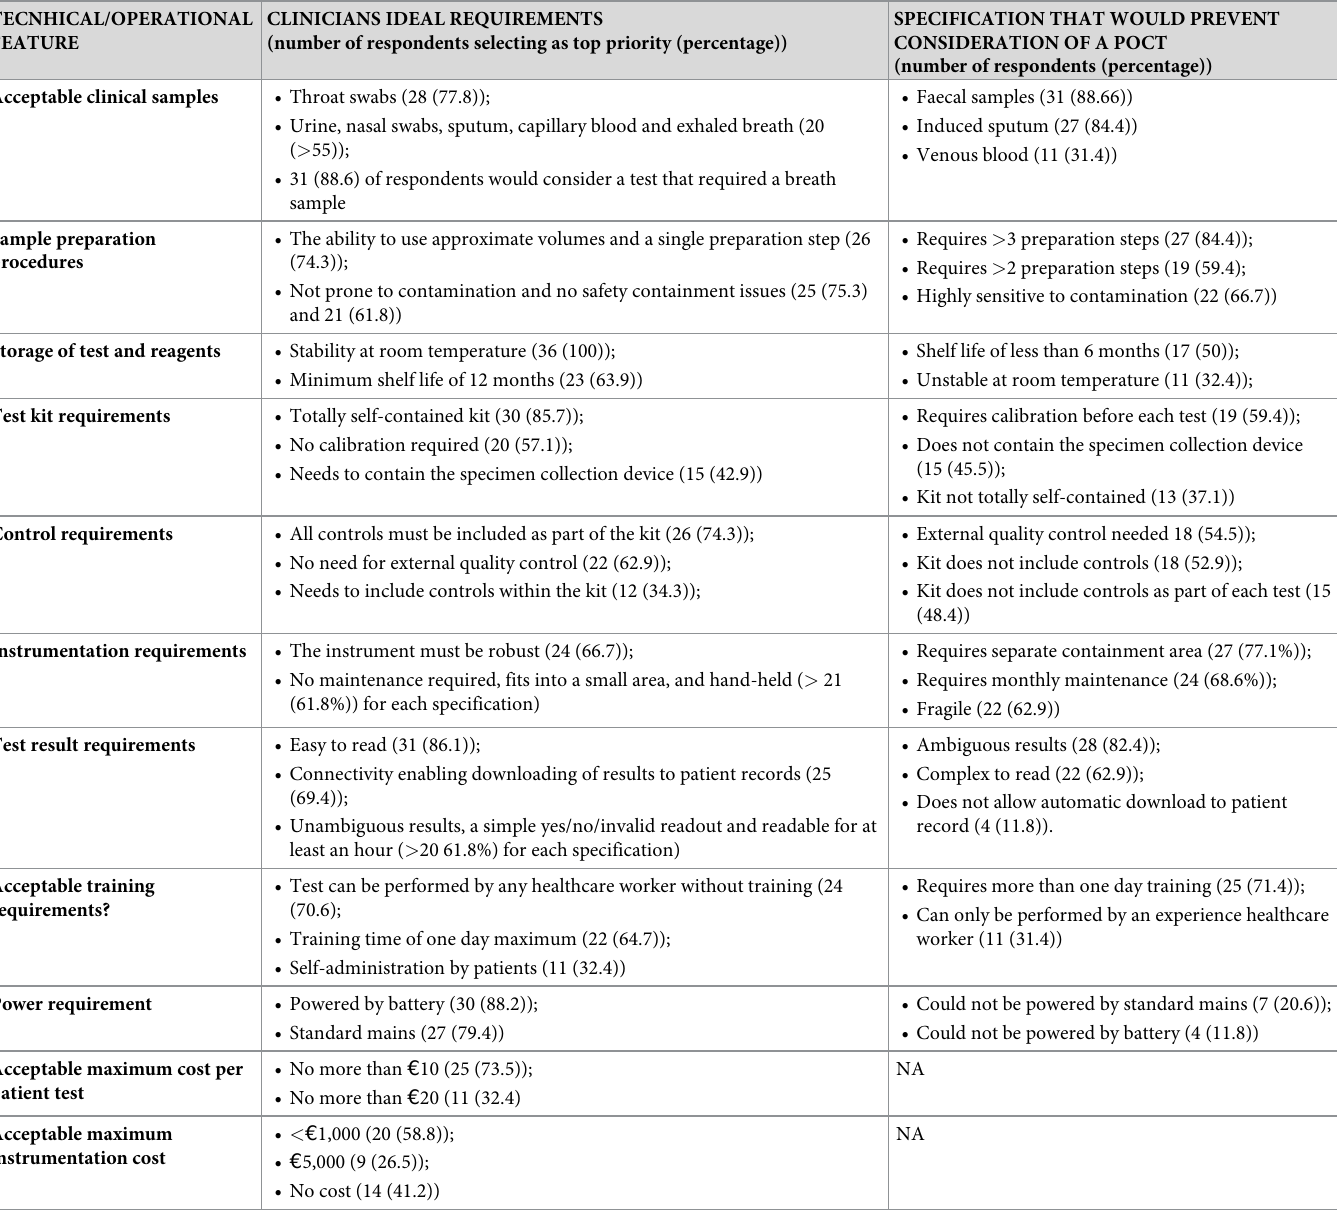
Table 4. Clinicians’ technical and operational requirements, and specifications preventing test